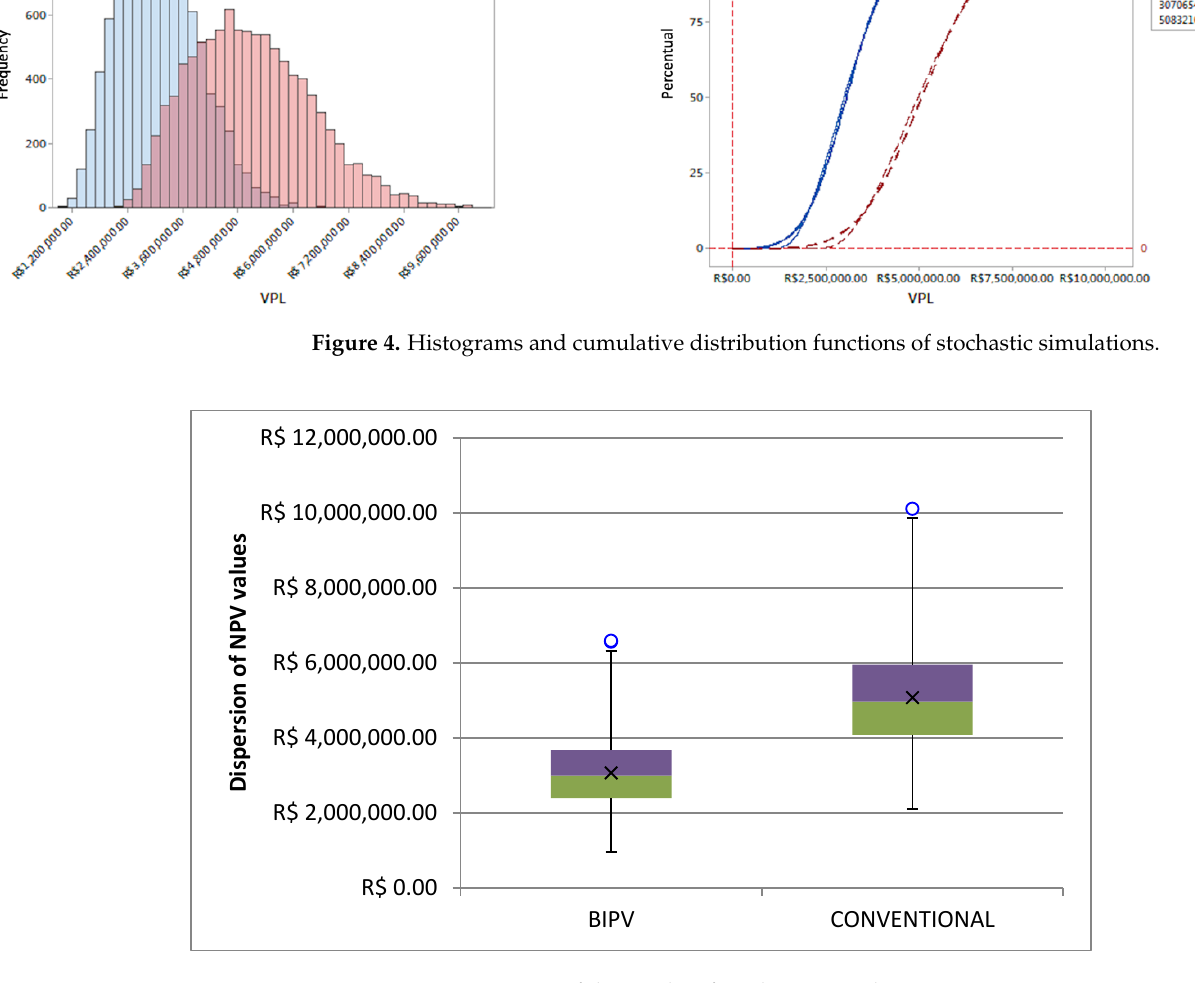
Figure 5. Representation of the results of stochastic simulations.